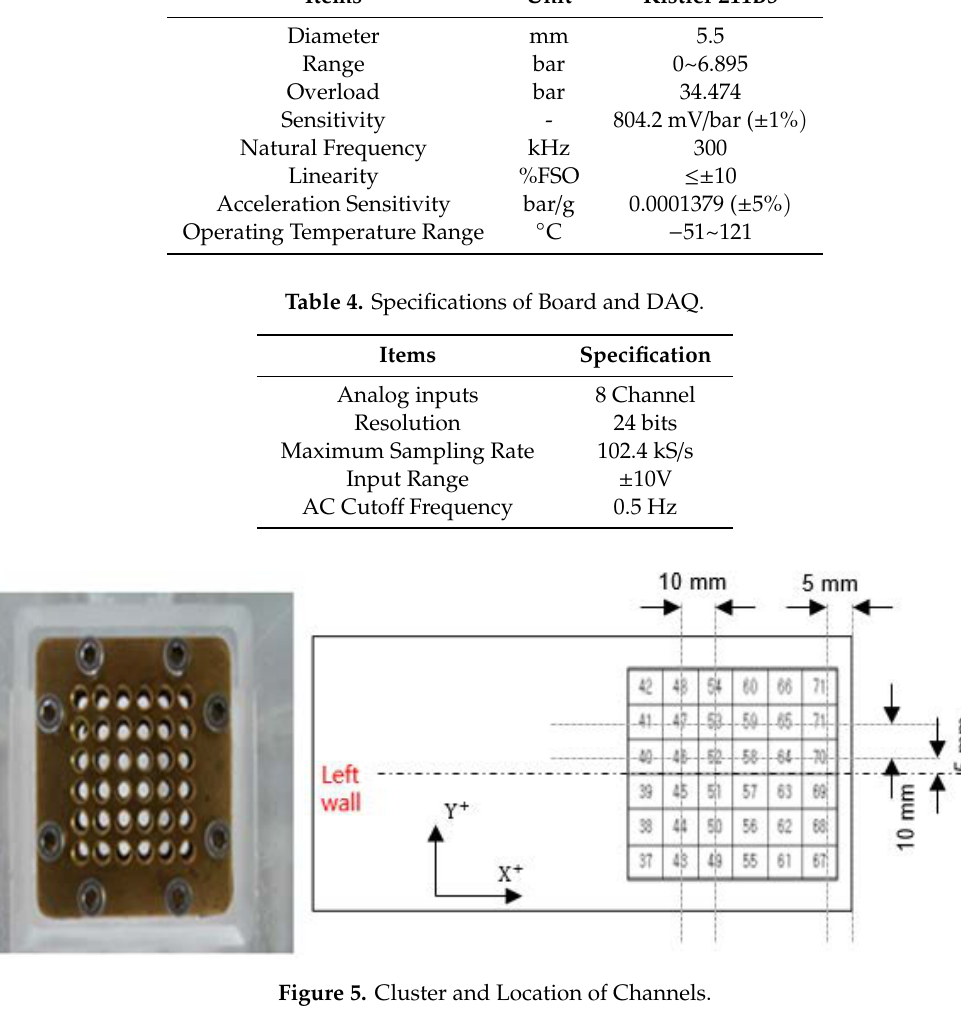
Figure 5. Cluster and Location of Channels.